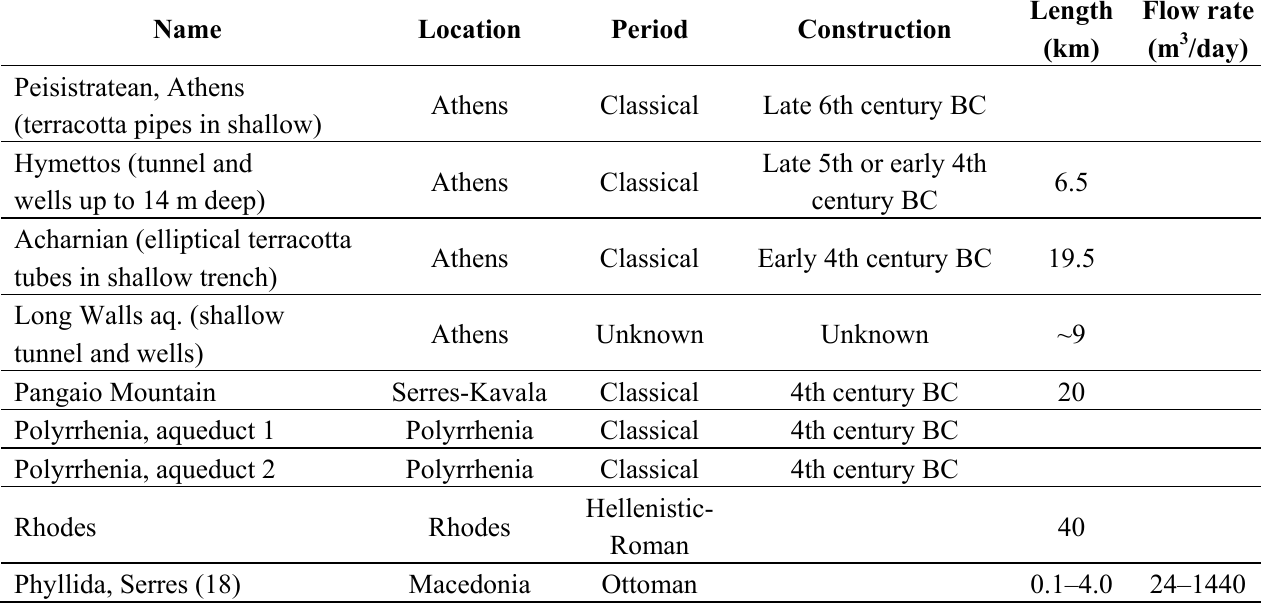
Table 2. Characteristics of major aqueducts-like qanats in Hellas